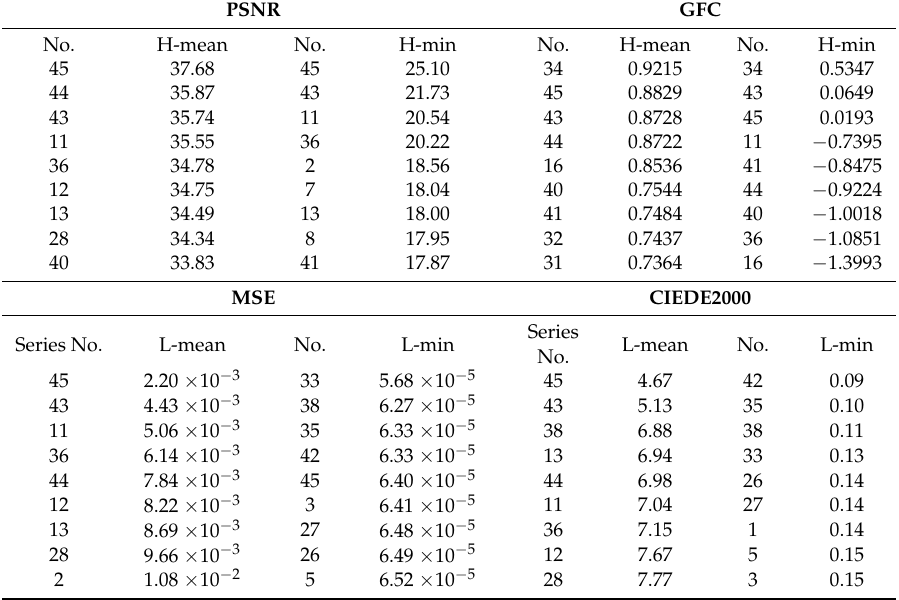
Table 1. Statistics of the top 20% best-performed filter set series, where the No. denotes the No. of filter set series; H-mean denotes descending order of the means; H-min denotes descending order of the minimums; L-mean denotes ascending order of the means and L-min denotes ascending order of the